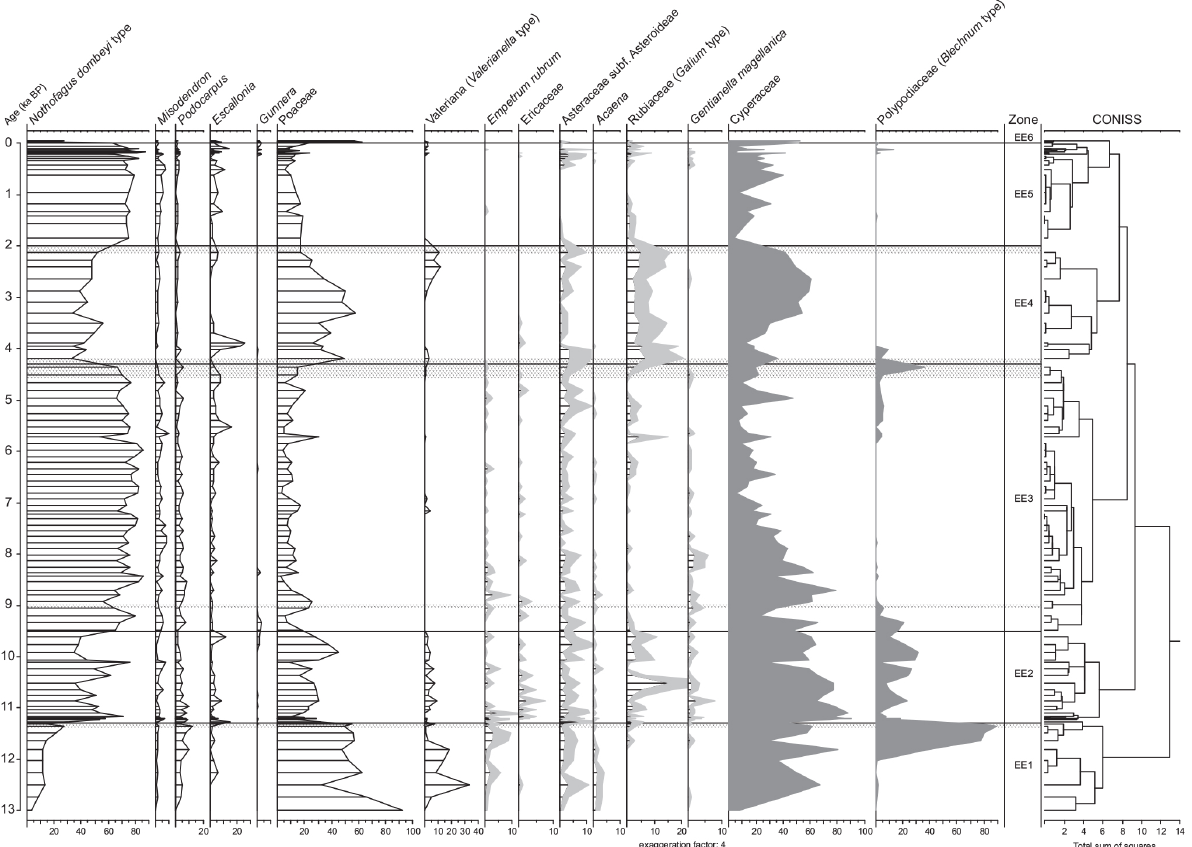
Figure 4. Percentage pollen diagram of Mallín El Embudo showing dominant taxa and CONISS analysis. Grey horizontal bands represent tephra